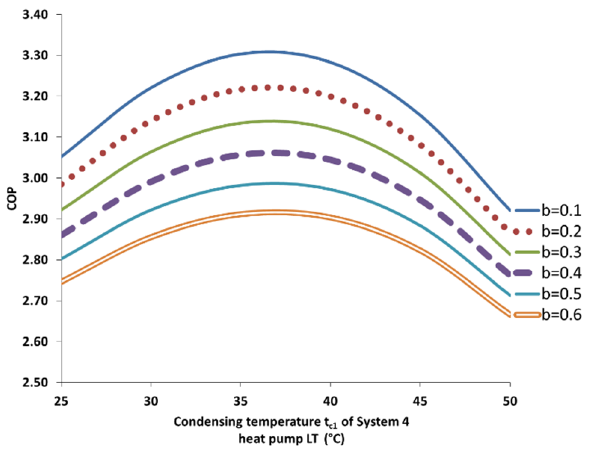
Figure 12. Coefficient of performance ( COP ) values of System 7.